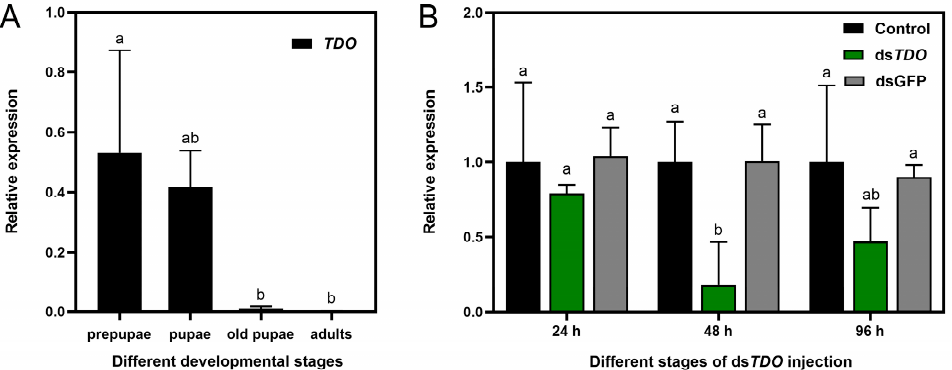
Figure 4. Relative expression of TDO in Monochamus alternatus at different stages of development ( A ) and 24, 48, and 96 h after the injection of 1 µg TDO dsRNA ( B ). Insects were microinjected with ddH 2 O (control), ds GFP, or ds TDO . Different letters indicate statistical differences in two-way ANOVA and Tukey’s test ( p < 0.05). Error bars indicate the SD of three independent biological rep- licates.